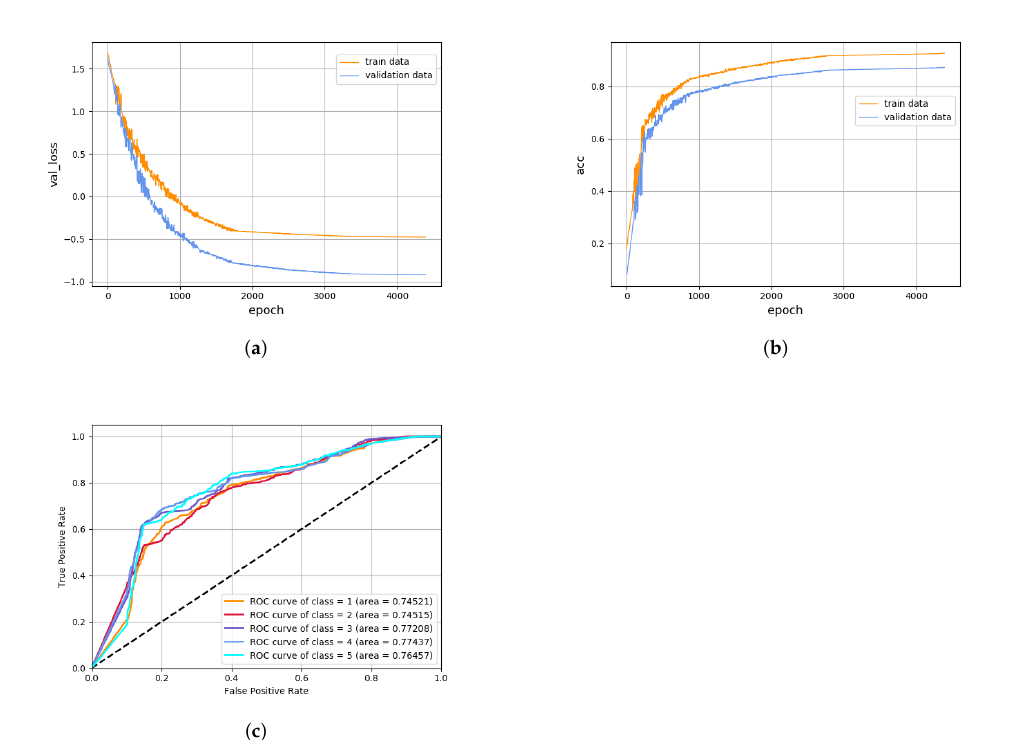
Figure 6. Training results of CVAEWD classifier and HMM classifier. ( a ) The loss trend graph of the CVAEWD model in the training set and the test set. ( b ) The accuracy trend graph of the CVAEWD model on the training set and the validation set. ( c ) HMM model ROC curve.